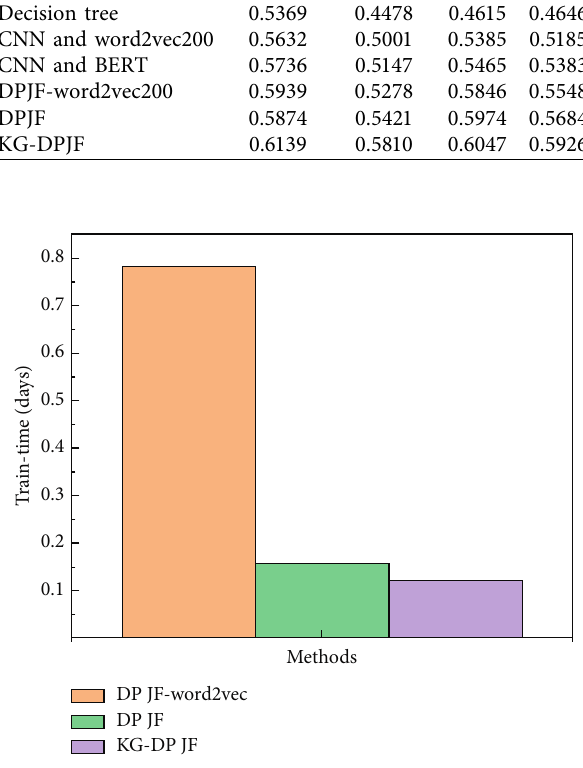
Figure 2: Performance comparison between word2vec and sen- tence-level